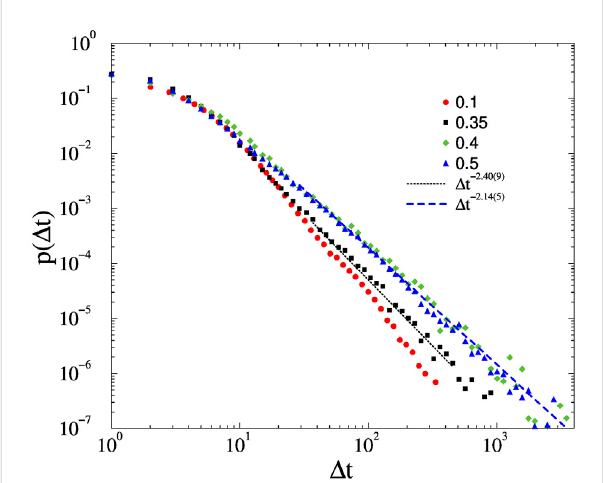
FIGURE 4 Avalanche duration distributions on the fruit- fl y connectome for different forces, shown by the legends and at K = 1.3, ϵ = 0.01. Dashed linesarePL fi tsfor Δ t > 100.Theinsetshowsthesteadystate σ ( Ω )asthe function of K , for excitation values F = 0.001, 0.0667, 0.1, 0.2, 0.3 (top to bottom).